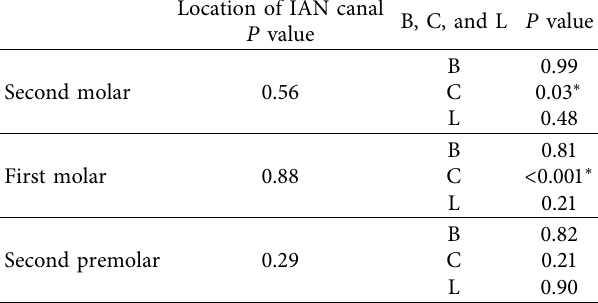
Table 2: Friedman test and paired samples t -test results showing the variation in the location of IAN canal and B, C, and L values between sides, respectively.